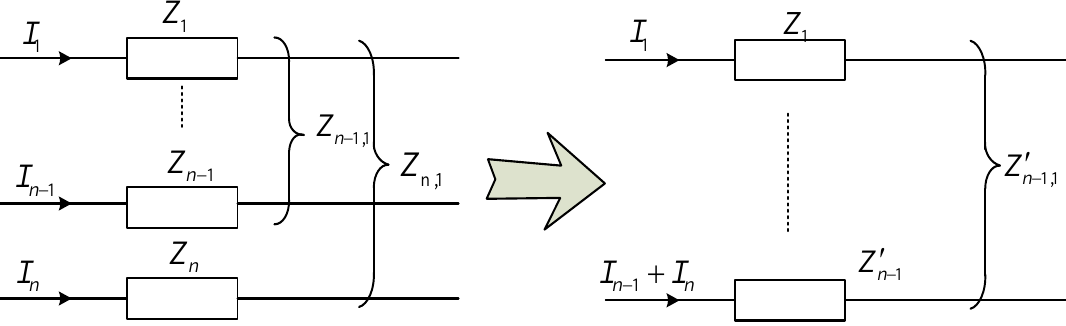
Figure 13. Impedance reduced-order principle.